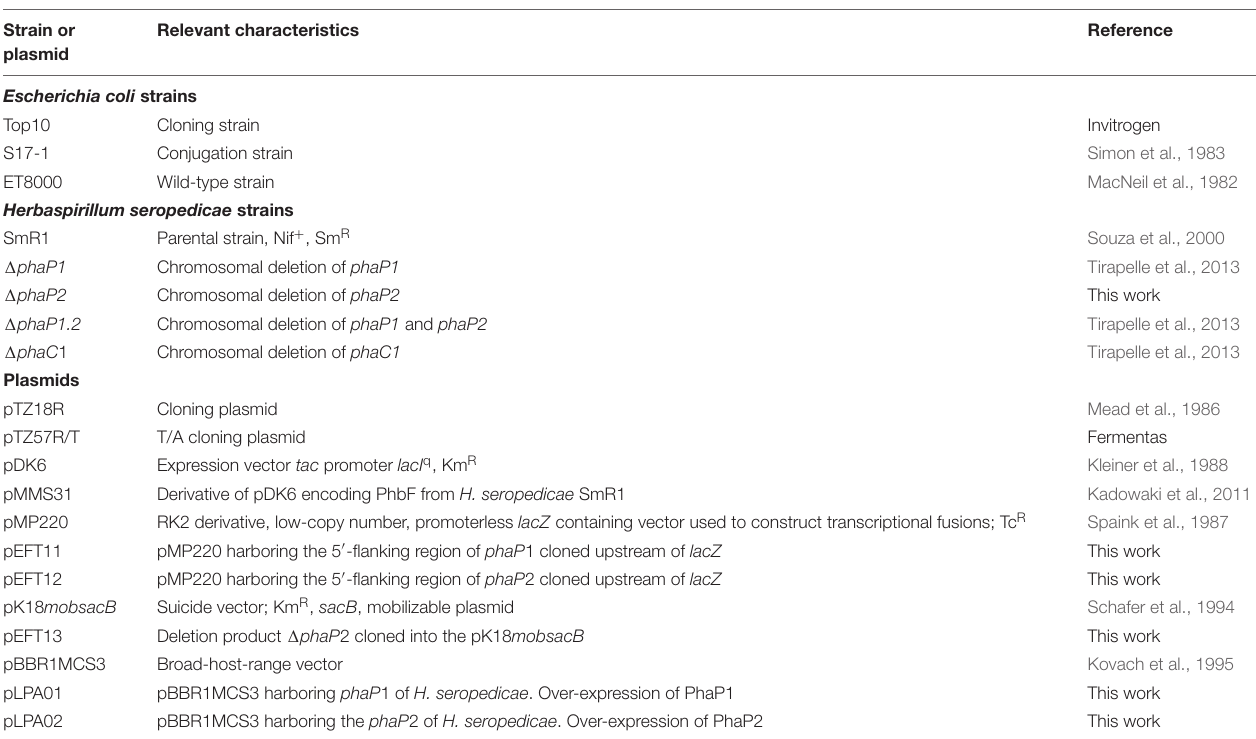
TABLE 1 | Bacterial strains and plasmids used in this